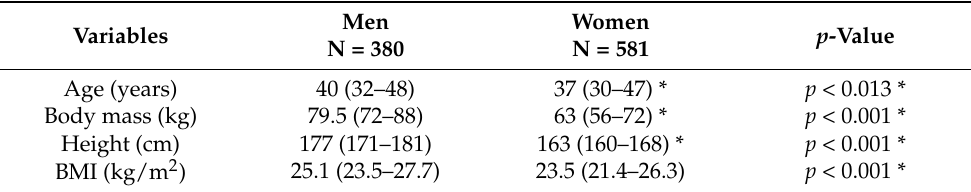
Table 1. Descriptive characteristics of